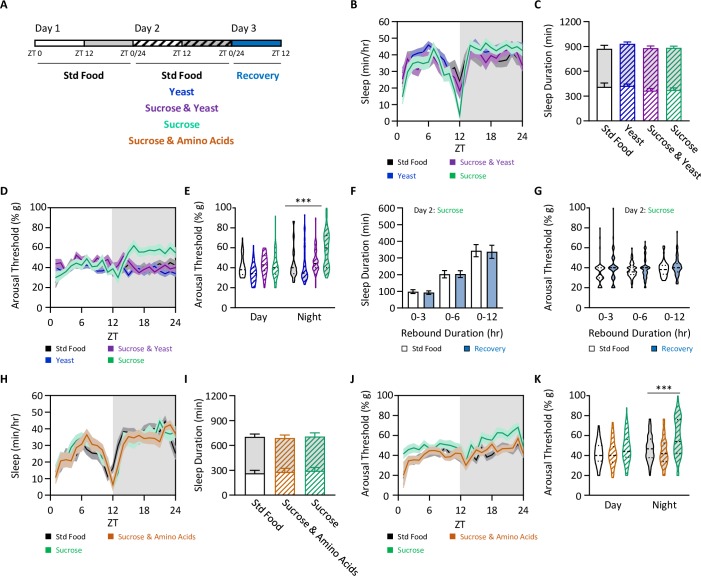
The absence of dietary protein increases sleep depth.(A) Sleep and arousal threshold measurements were taken over a 24 hr period from flies fed standard food media, 2% yeast, 2% yeast and 5% sucrose, 5% sucrose, or 5% sucrose and 2.5x amino acids. Comparisons were then made between flies fed standard food media and each of the subsequent diets. (B) Sleep profile. (C) Diet does not affect sleep duration (two-way ANOVA: F1,396 = 0.3886, P = 0.7612). (D) Arousal threshold profile. (E) Diet does affect nighttime sleep depth (REML: F3,183 = 11.70, P<0.0001, N = 46–53). Post hoc analyses revealed a significant increase in nighttime arousal threshold when flies are fed 5% sucrose, compared to standard food (day: P>0.9999; night: P<0.0001). (F-G) There is no homeostatic rebound following 24 hrs of sucrose feeding. Homeostatic rebound was measured as described in Fig 1B and was assessed in 3-, 6-, and 12-hr increments. (F) There is no difference in sleep duration (two-way ANOVA: F1,312 = 0.0344, P = 0.8530). (G) There is no difference in arousal threshold (REML: F1,88 = 2.738, P = 0.1005, N = 46–53). (H-K) Adding amino acids to sucrose restores sleep depth. (H) Sleep profile. (I) Again, diet does not affect sleep duration (two-way ANOVA: F2,140 = 0.0193, P = 0.9808). (J) Arousal threshold profile. (K) Diet does affect arousal threshold (REML: F2,180 = 11.98, P<0.0001, N = 20–33). Post hoc analyses revealed a significant increase in nighttime arousal threshold when flies are fed 5% sucrose, compared to standard food (day: P = 0.1206; night: P<0.0001) and when sucrose is supplemented with amino acids (day: P = 0.1362; night: P<0.0001). For profiles, shaded regions indicate +/- standard error from the mean. White background indicates daytime, while gray background indicates nighttime. Error bars represent +/- standard error from the mean. For arousal threshold measurements, the median (dashed line) as well as 25th and 75th percentiles (dotted lines) are shown. *** = P<0.001.